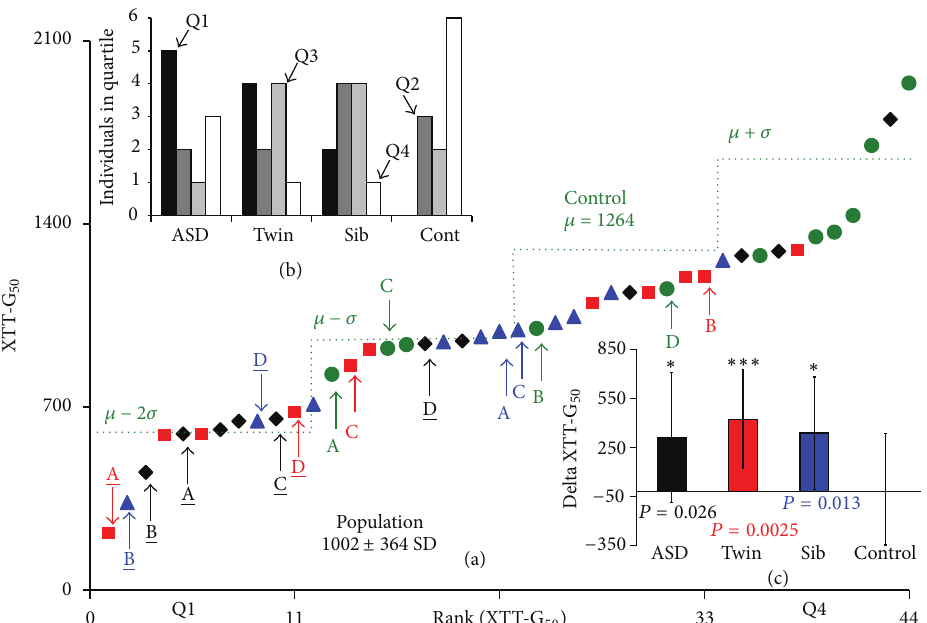
Figure 4: This figure shows the concentration of thimerosal which induced a 50% inhibition of growth at day 5, measured by the XTT method (XTT-G 50 ). In (a) we have ranked the color-coded cells in terms of sensitivity to thimerosal and have highlighted four family groups: A, B, C, and D. Underlined letters denote cell lines we believe have a heightened sensitivity to thimerosal. The distribution of the control population is indicated by the green line that indicated mean + SD, mean, mean – SD, and mean − 2SD. Distribution of Cells Types. In the upper insert, (b) we show the distribution of the four cells types, ASD, unaffected Twin, unaffected Sibling, and external age/sex matched control, in the four quartiles of the ranked distribution. There is less clustering of the ASD derived cells, but as with the LDH assay, the external controls are distributed to the right hand side of the rankings. Test for Systemic Errors. In the second insert, (c) we show that there is no systemic correlation between low XTT-G 50 ’s in cells drawn from families from an ASD background and their respective controls. The plot in (c) shows the average and standard deviation of the difference between the appropriate age/sex matched control and each of the ASD familial XTT-G 50 . The positive values indicate that cells from the affected families are more sensitive than the external controls. The 𝑃 values indicate the results from a one-tailed t -test, 𝑛 = 11 , with ( ∗ ) indicating < 0.05 and ( ∗∗∗ ) indicating <